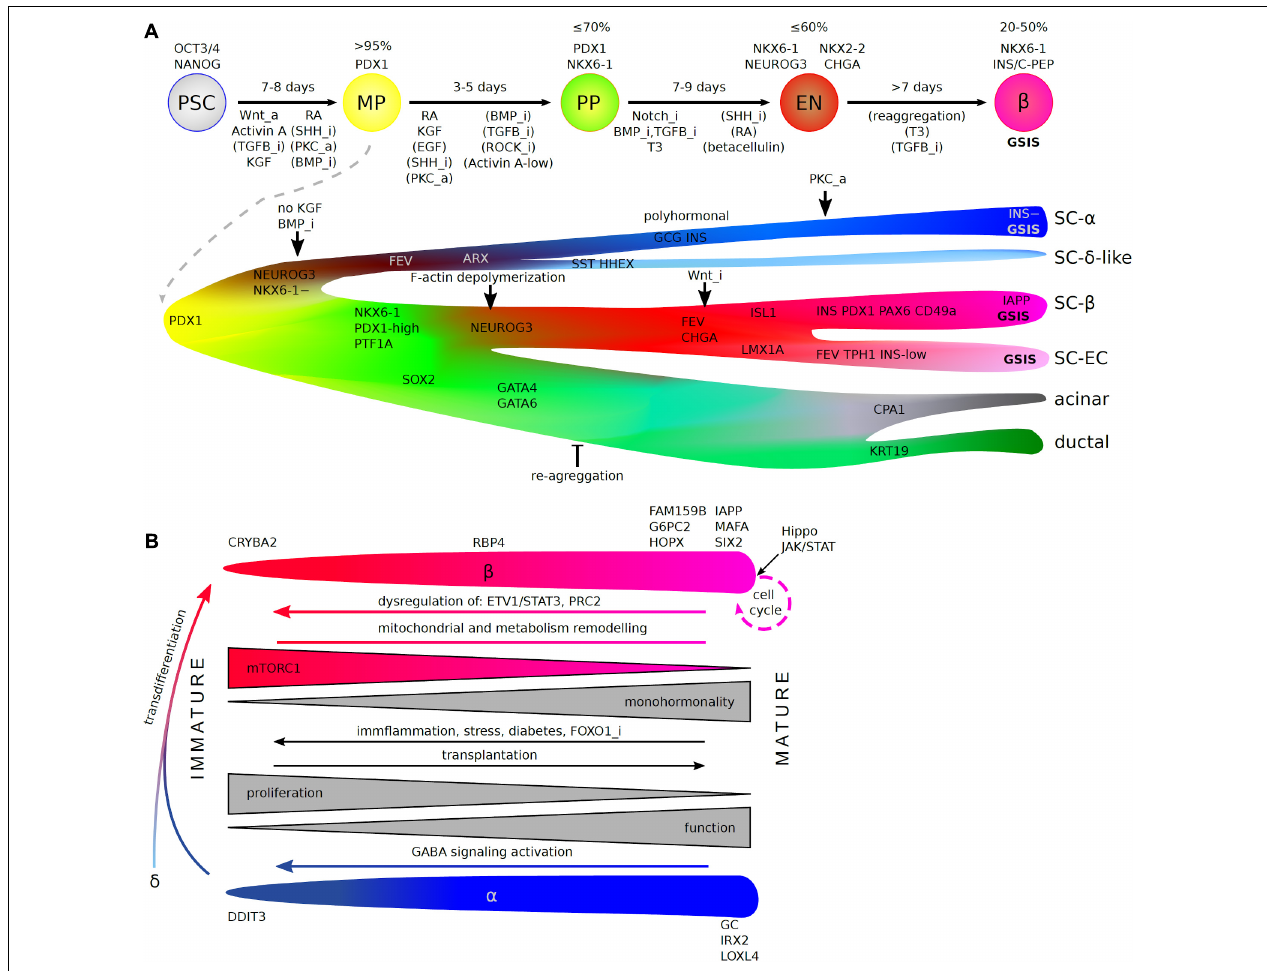
FIGURE 2 | scRNA-Seq insight into in vitro hPSC differentiation toward human pancreatic β -cells (A) and endocrine cell maturation (B) . (A) (Top) Stages of differentiation protocols (arrows), which recapitulate consecutive pancreas development steps in vivo (circles). Denoted are: a length of each stage (above arrows, in days), genes commonly used to estimate differentiation efficiency (% + for stage markers out of all cells), and pathways that are inhibited (“_i”) or activated (“_a”) during each stage (below arrows). Pathways without brackets are essential for the process and applied in all commonly used protocols, while brackets indicate pathways regulated in a fraction of protocols. PSC—pluripotent stem cells, MP—multipotent progenitors, BP—bipotent progenitors, EN—endocrine lineage (endocrine progenitors and immature endocrine cells), β — β -cells, GSIS—glucose stimulated insulin secretion. (Bottom) A detailed view on the differentiation based on scRNA-Seq reveals the origin of non- β -cell specific populations that deteriorate differentiation efficiency and points to branching at which the protocols could be refined. Factors identified in scRNA-Seq studies that improve specific lineage choices are denoted. SC—stem cell-derived, EC—enterochromaffin cells. (B) Maturation of β - and α - cells including molecular changes and marker genes along the process. Dedifferentiation (reverse arrows), transdifferentation, and re-entering cell cycle are possible as physiological compensatory mechanisms, in pathology and when artificially forced by identified factors, with potential use in